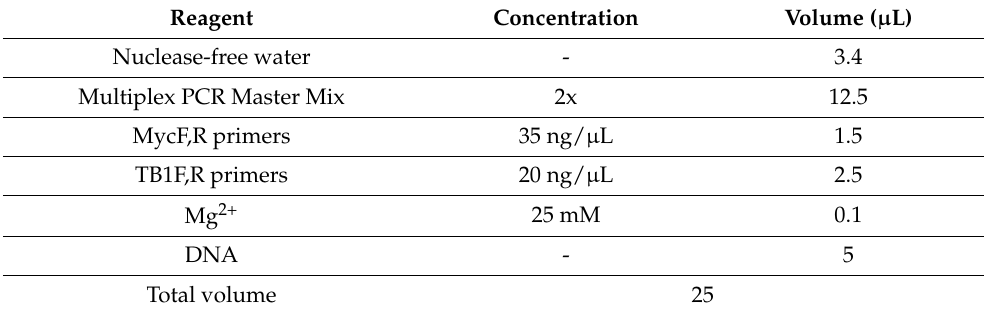
Table 2. Reaction components.